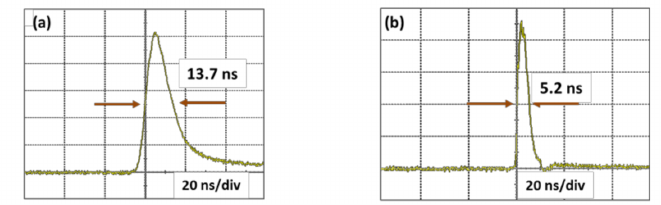
Figure 7. Temporal profiles of the pump light ( a ) and output signal light ( b